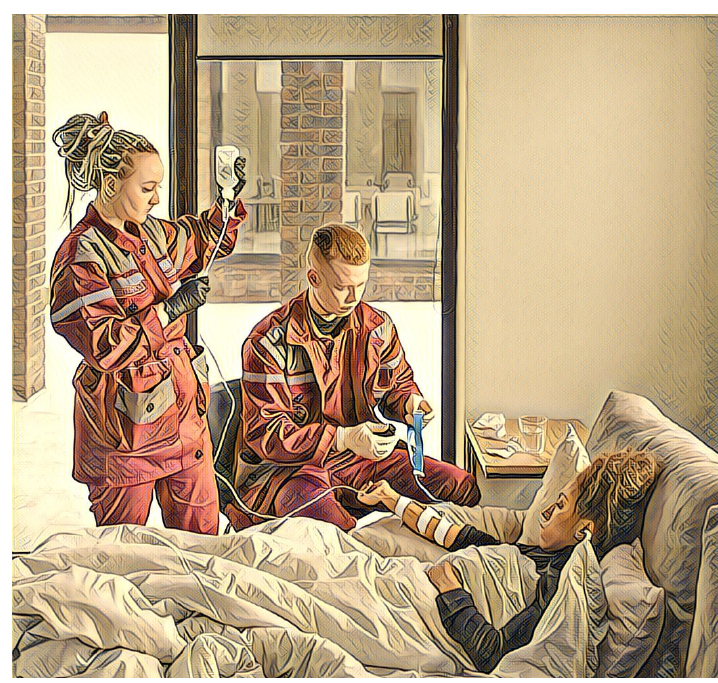
Figure 6. An illustration of SAIT for paramedics